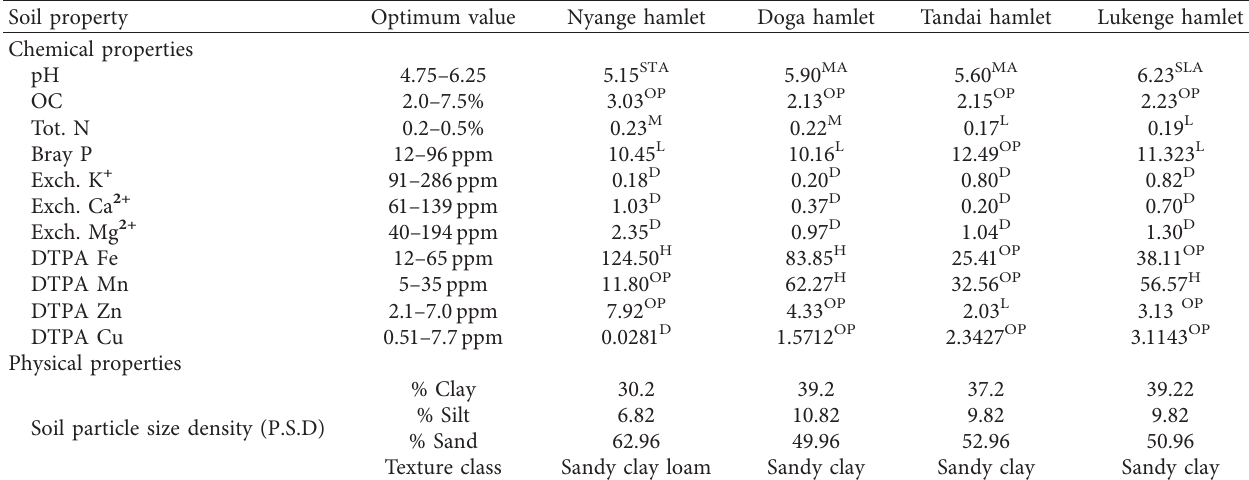
Table 1: Chemical and physical properties of soil (0–20cm depth) in Tandai village.